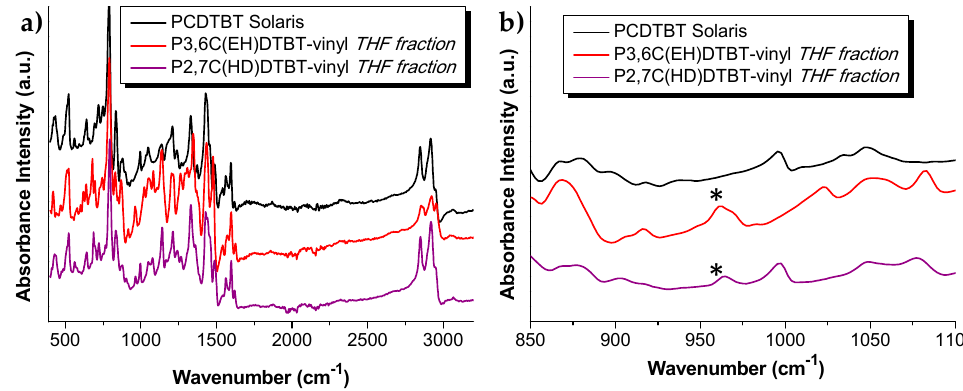
Figure 2. ( a ) ATR spectra of commercial PCDTBT, P3,6C(EH)DTBT-vinyl and P2,7C(HD)DTBT-vinyl THF fractions. ( b ) Enlarged region of the ATR spectrum from 850 to 1100 wavenumbers. The asterisks (*) in Figure 2b, indicate the peaks owing to the ω -end double bonds.